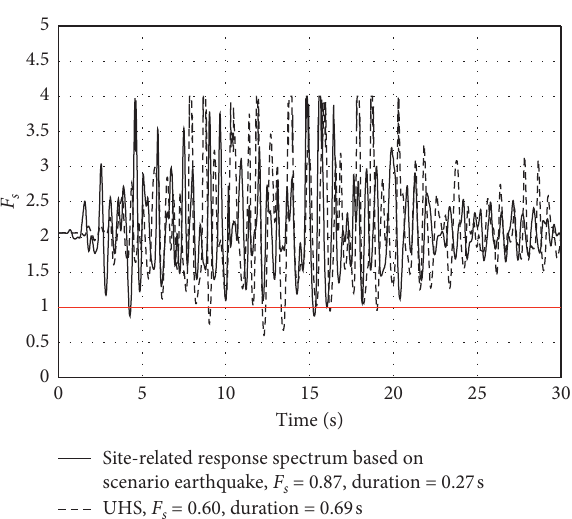
Figure 9: Minimum downstream slope safety factor (Fs) with time using different response spectra.